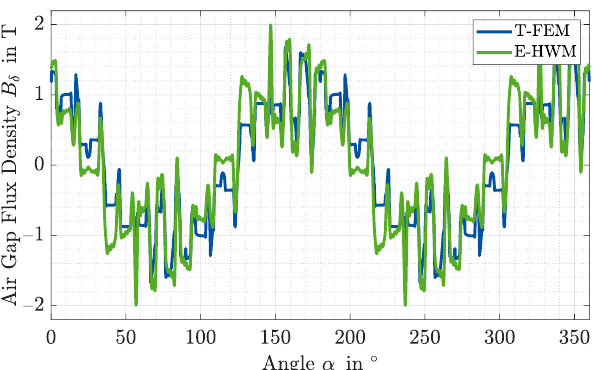
Figure 5. Simulated air gap flux density of an IM with non-linear stator and rotor magnetic material properties using the T-FEM and